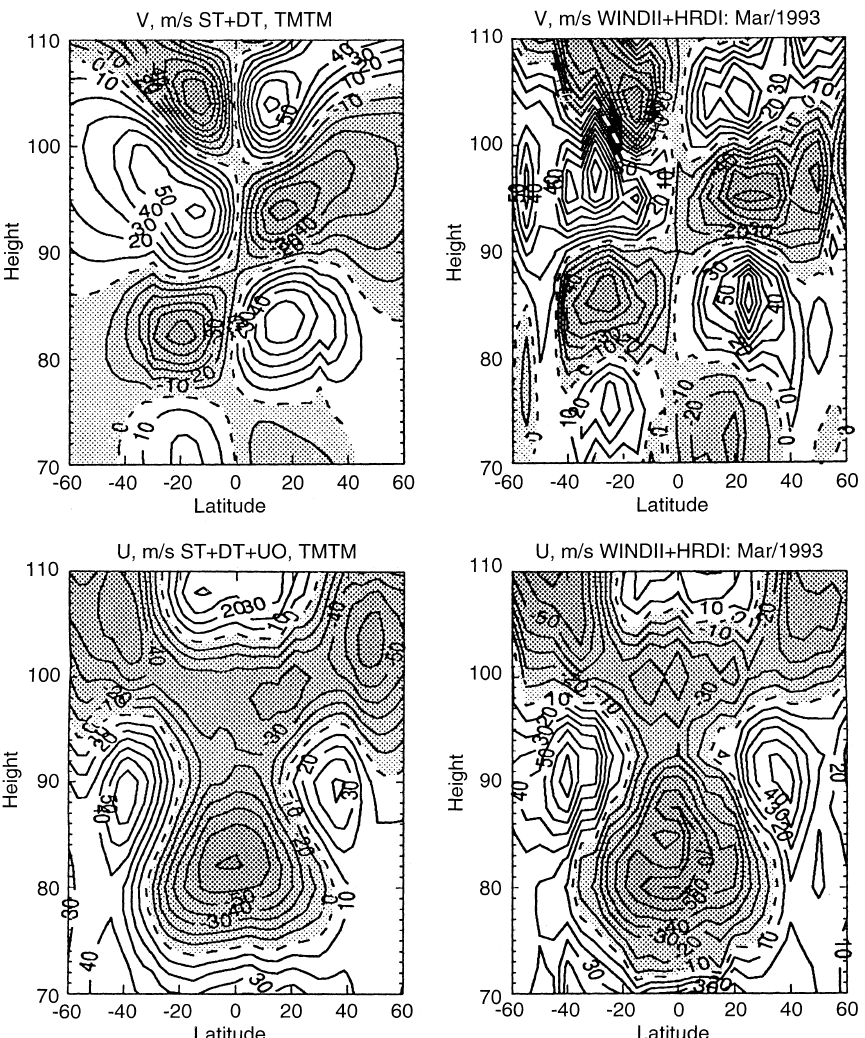
Fig. 7. Meridional and zonal winds predicted by tuned mechanistic tidal model results and HRDI/WINDII me- ridional and zonal wind observations in March 1993 at 12 LT. The mean zonal wind (not shown) is estimated by subtr- acting the predicted diurnal zonal wind patterns from the satellite observations. For simulation of the semidiurnal tides, the derived tidal dissipation from the diurnal TMTM simulation